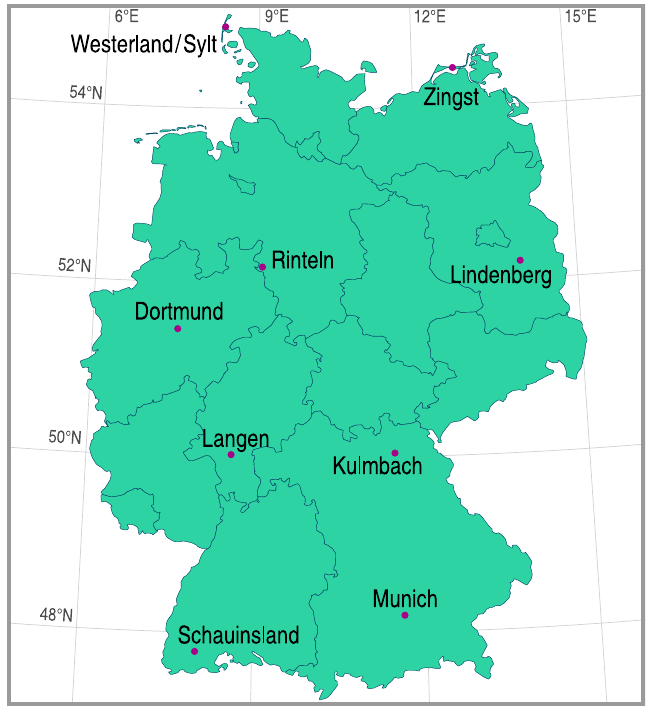
Figure 2. Map of Germany showing the geographical position of the nine stations of the German solar UV monitoring network which provided erythemal irradiance data.